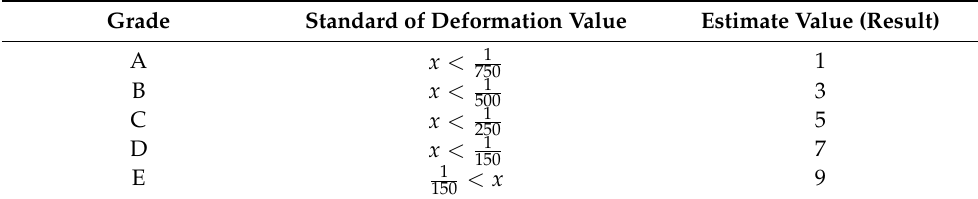
Table 4. Design standard of deformation (KDS).